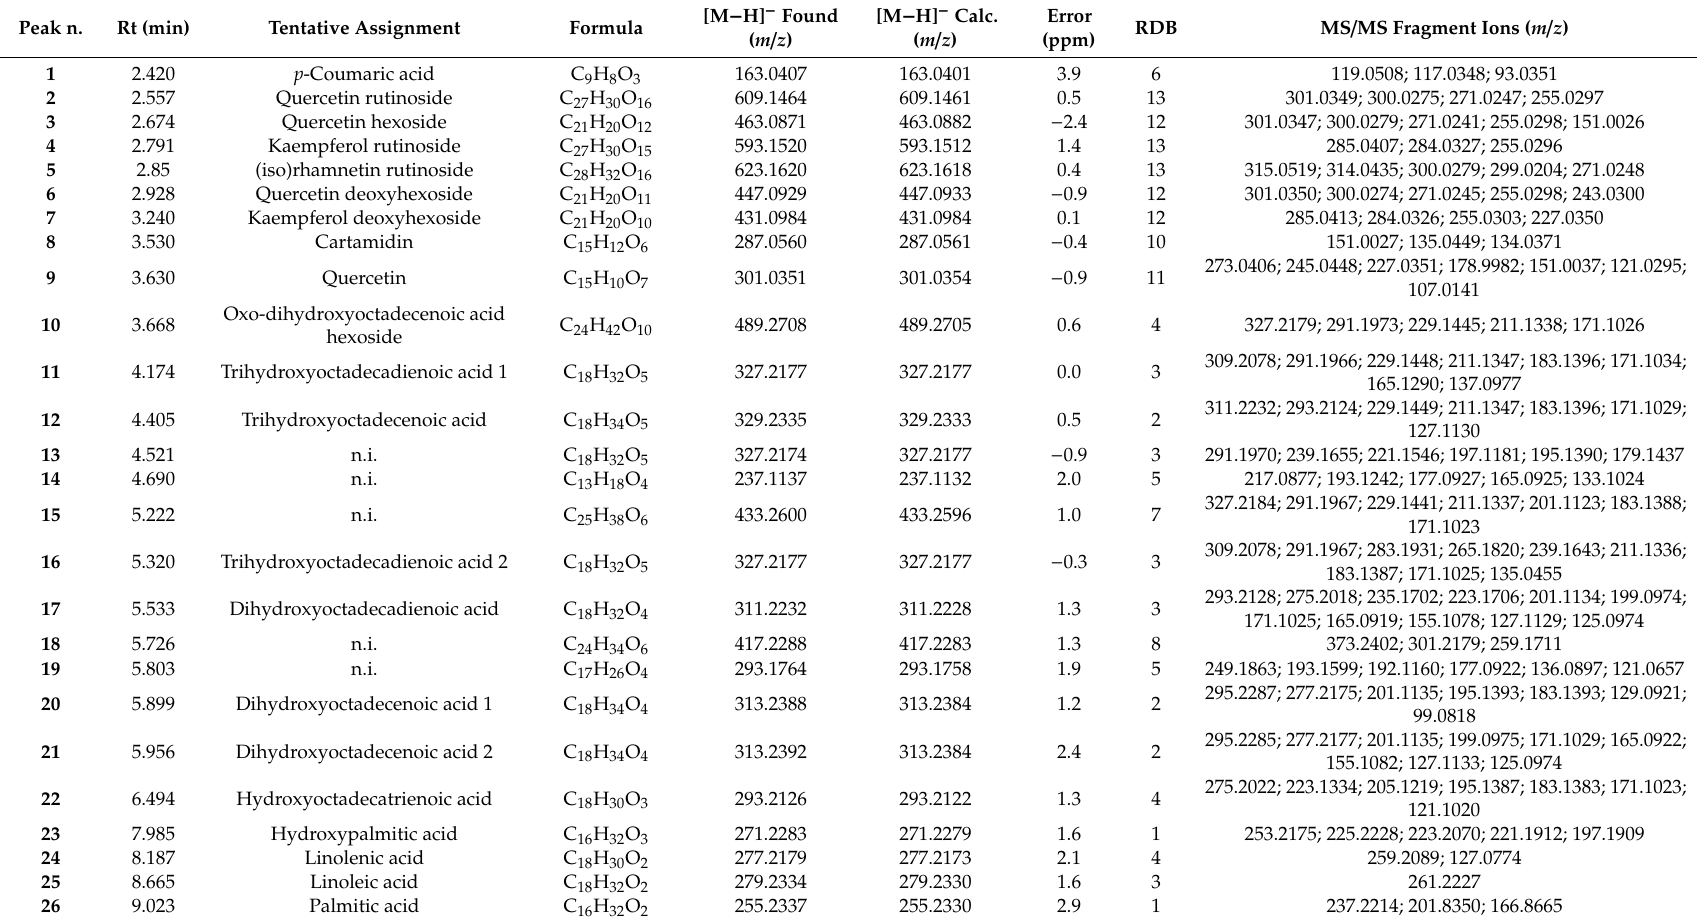
Table 2. TOF-MS and TOF-MS 2 data of compounds putatively identified in ZLF-O fraction. Peak